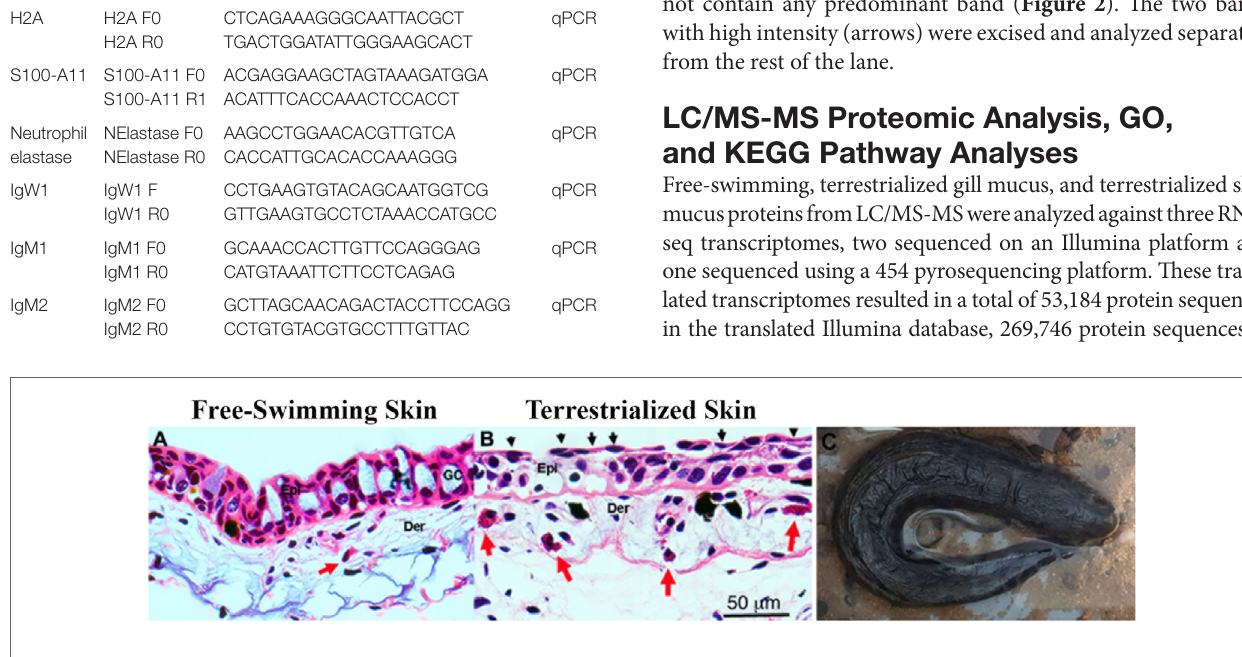
FigUre 1 | (a) Hematoxylin and eosin staining of free-swimming and (b) terrestrialized Protopterus dolloi skin paraffin sections. Skin sections show significant infiltration of granulocytes (red arrows) in the dermis (Der); epidermis (Epi), and goblet cells (GO). The black arrows indicate flattened keratinocytes after terrestrialization. (c) Image of a P. dolloi 4 days after the initiation of the induction phase actively secreting mucus from its